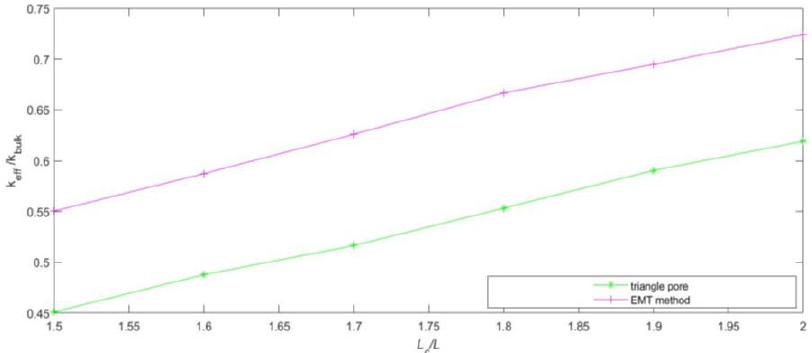
Figure 8. The effective thermal conductivity with the EMT method and the MCBU method with the